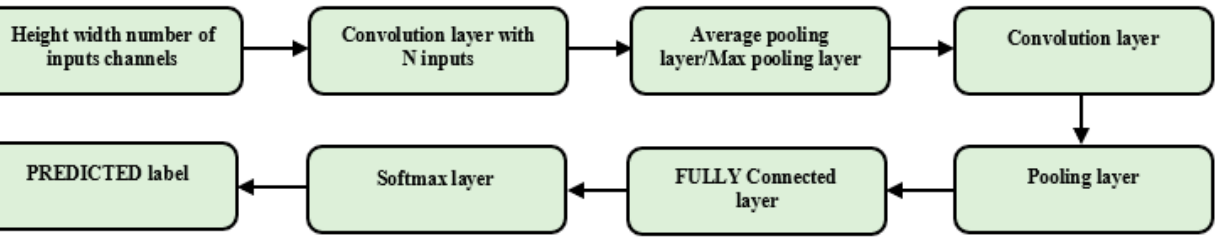
Table 2. Implementation variables